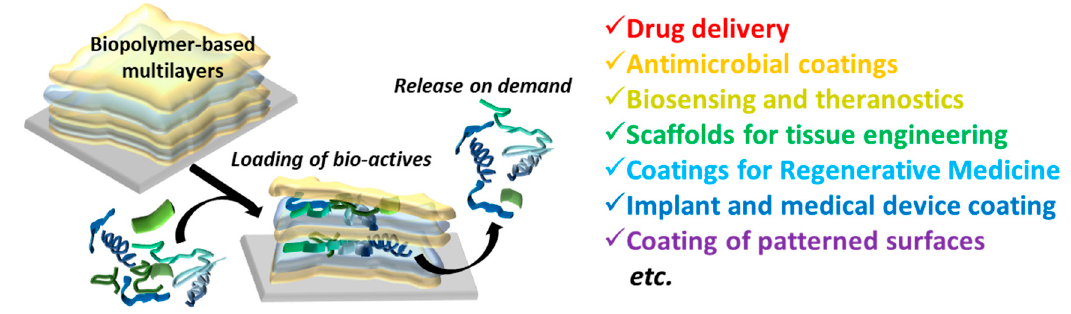
Figure 1. Multilayer assembly made of biogenic polyelectrolytes and their biomedical applications.